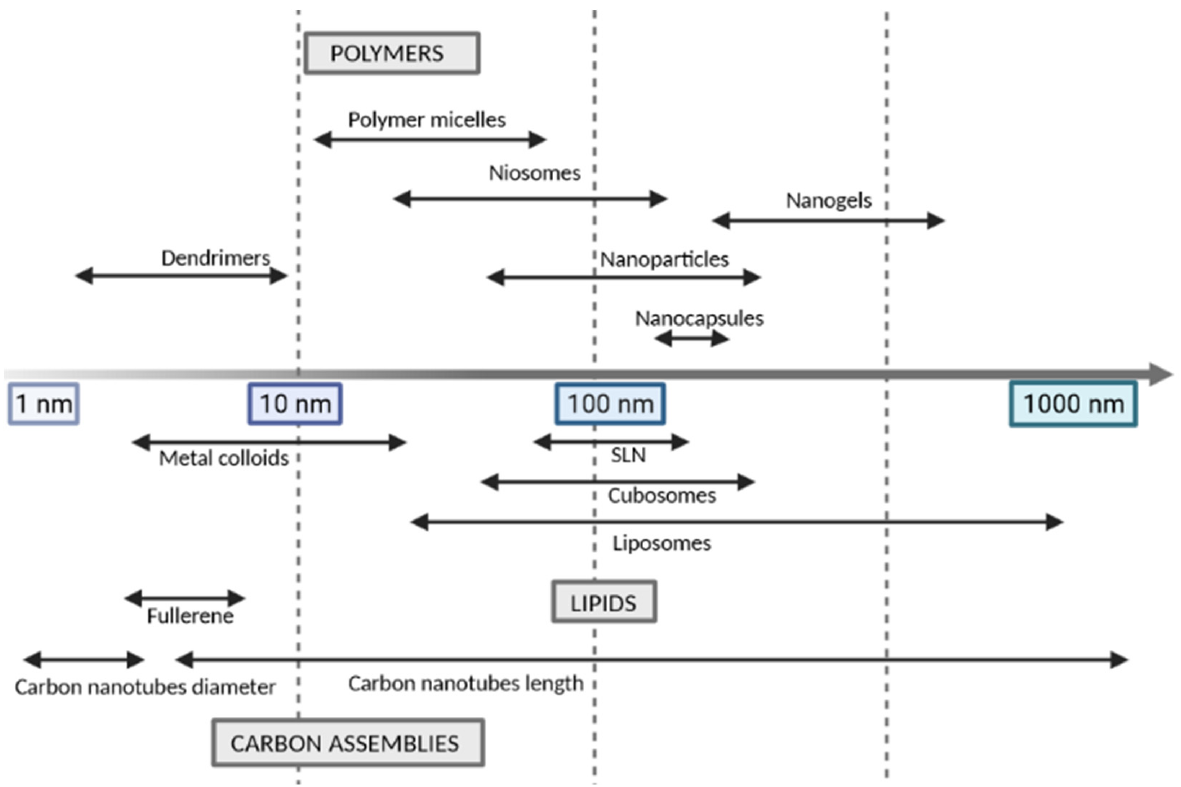
Figure 3. Graphical representation of different types of nanomaterials and their corresponding size range [own drawing].